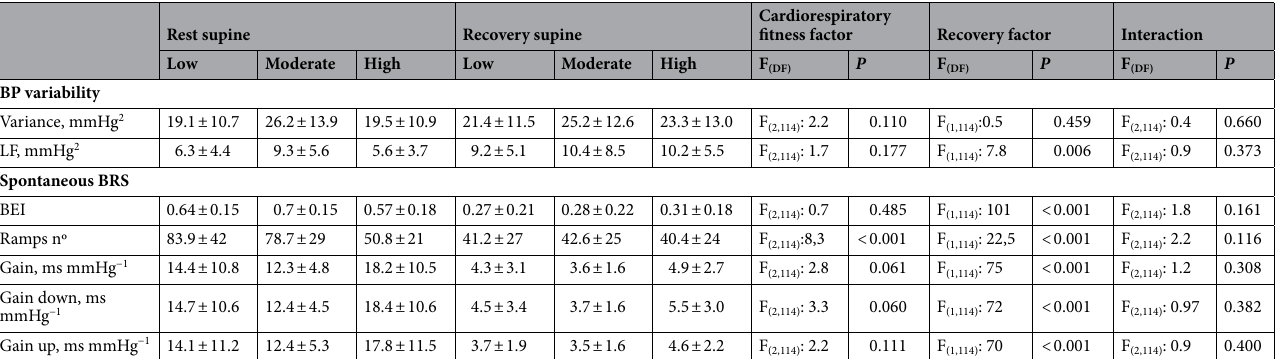
Table 4. Volunteer’s cardiovascular autonomic parameters evaluated at rest and supine positions. Data are presented as mean ± SD. BP blood pressure, mmHg millimeter of mercury, LF low frequency, BRS